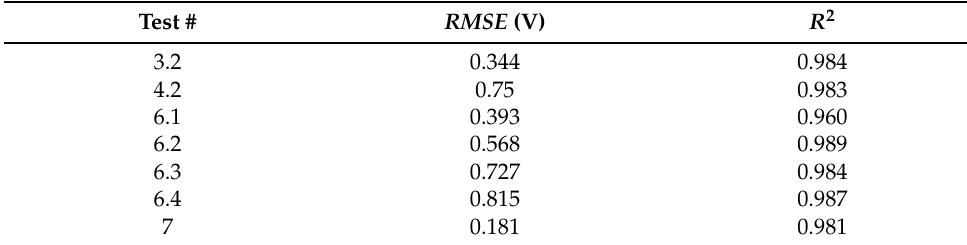
Table 7. Battery Testing Voltage Metrics.